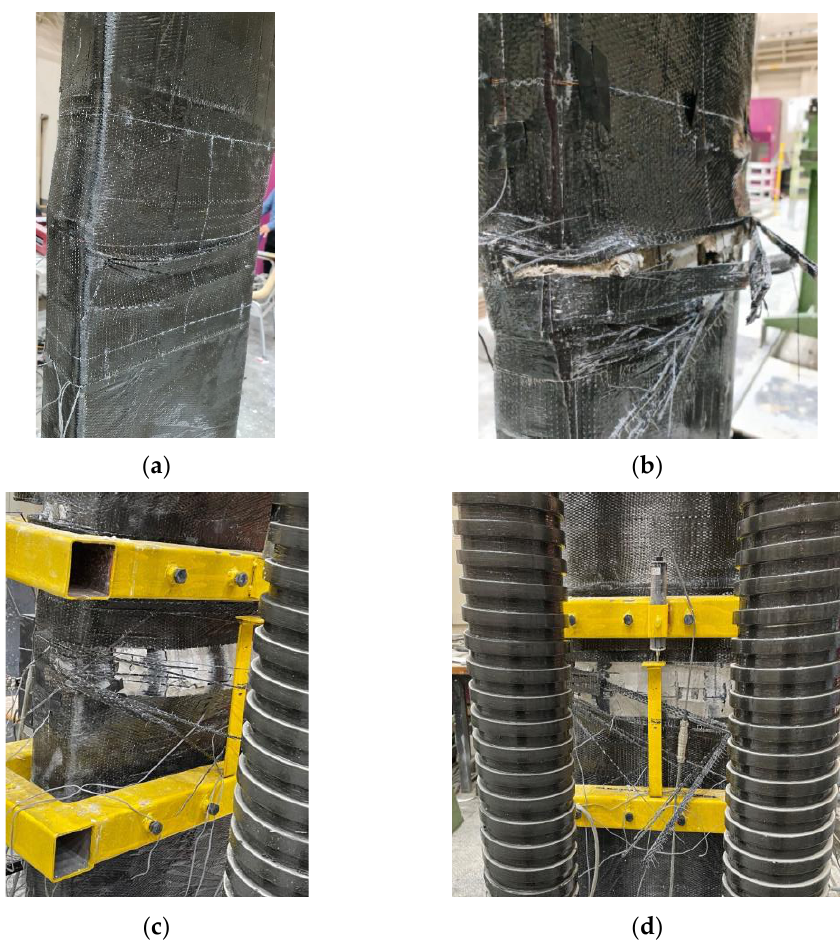
Figure 13. Failure mode of strengthened columns: ( a ) SW1; ( b ) SW2; ( c ) SW3; ( d ) SW4.